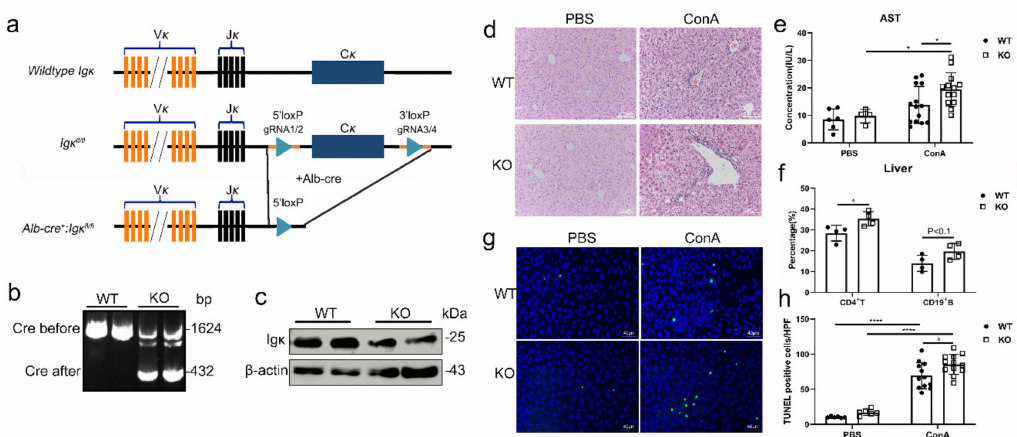
Figure 3. Hepatocyte-derived Ig κ inhibited ConA-induced liver injury in vivo. The wild type (WT) and knockout (KO) mice were treated with ConA or PBS and sacrificed 24 h later. ( a ) Scheme for generation of hepatocyte-specific Ig κ knockout mice. LoxP sites were inserted to flanking exon in Ig κ gene constant region. Mice homozygous for loxP insertion (fl / fl) were crossed with mice expressing Cre recombinase under control of the Alb-cre promoter. ( b ) PCR analysis of Ig κ transcript in liver tissue of wild type (WT) and knockout (KO) mice. ( c ) Western blot analysis of Ig κ protein in liver tissue of WT and KO mice. ( d ) Liver sections of WT and KO mice were stained with hematoxylin and eosin and representative images are shown. ( e ) Levels of serum AST were measured. ( f ) Percentage of liver infiltrated lymphocytes was analyzed in WT and KO mice stimulated by ConA or phosphate-bu ff ered saline (PBS). ( g ) Transferase-mediated deoxyuridine triphosphate nick end-labeling (TUNEL) analysis of primary hepatocytes in WT and KO mice. ( h ) The number of TUNEL-positive cells per high power field was calculated. The results presented were from three independent experiments, and each error bar represents the standard deviation. Statistical analysis was performed by one-way analysis of ANOVA. * p < 0.05; **** p <